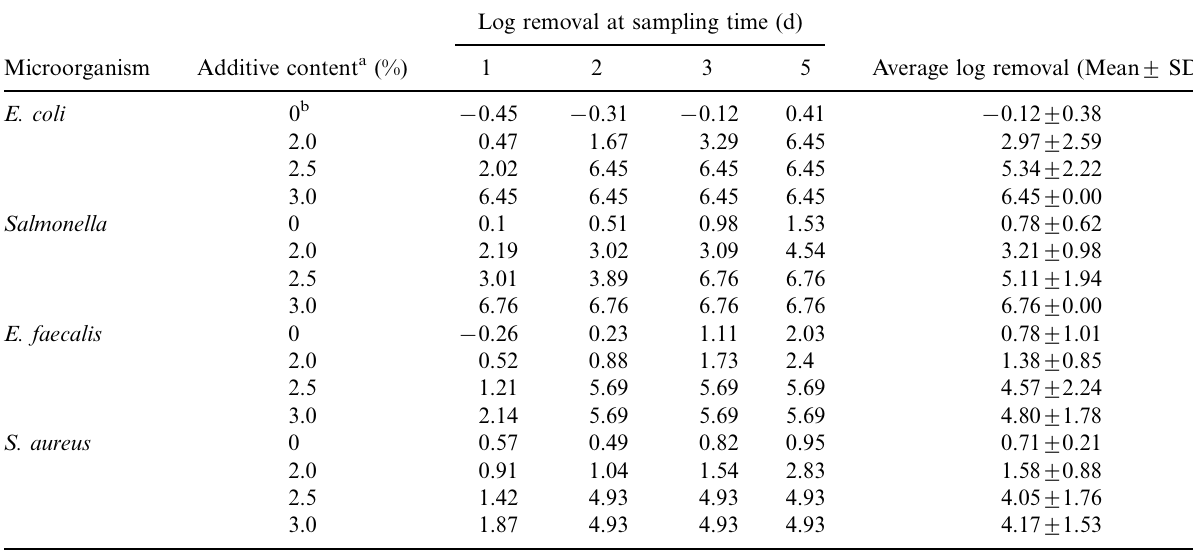
Table 4. Log removal for E. coli , Salmonella , E. faecalis , and S. aureus during cattle manure composting with addition of different contents of CaCN 2 at 30 8